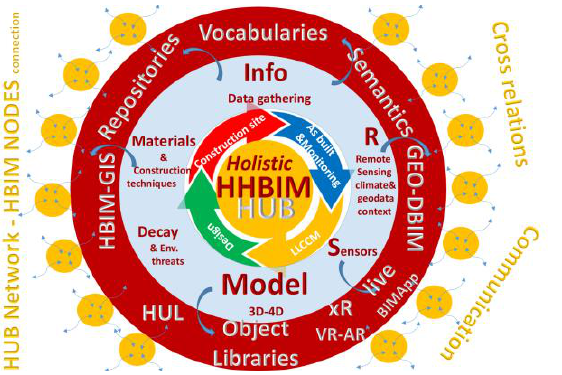
Figure 4. Holistic HBIM Hub workflow scheme: hub network connecting the HBIM nodes